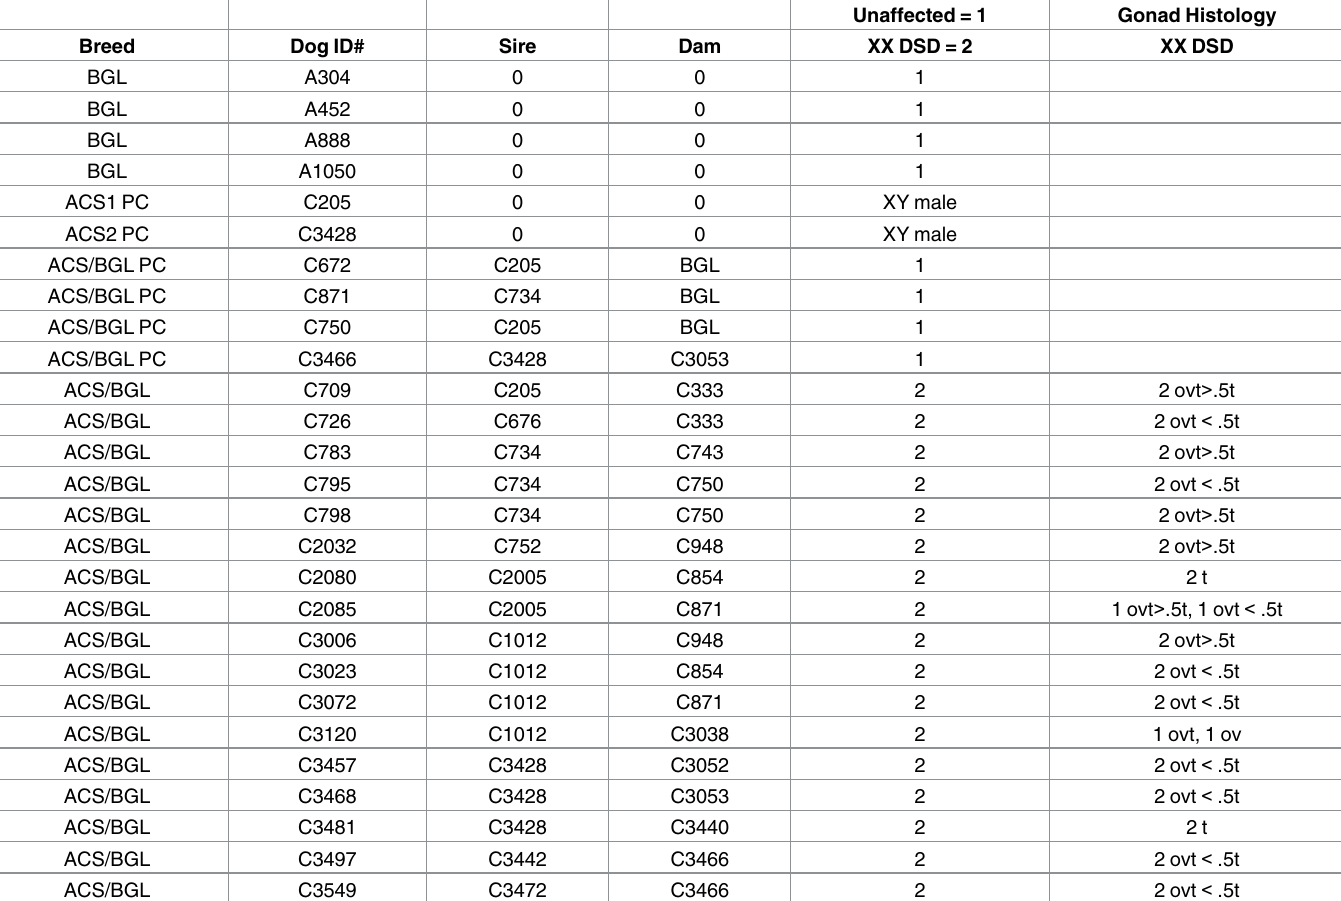
Table 1. Characteristics of dogs included in GWAS (N =